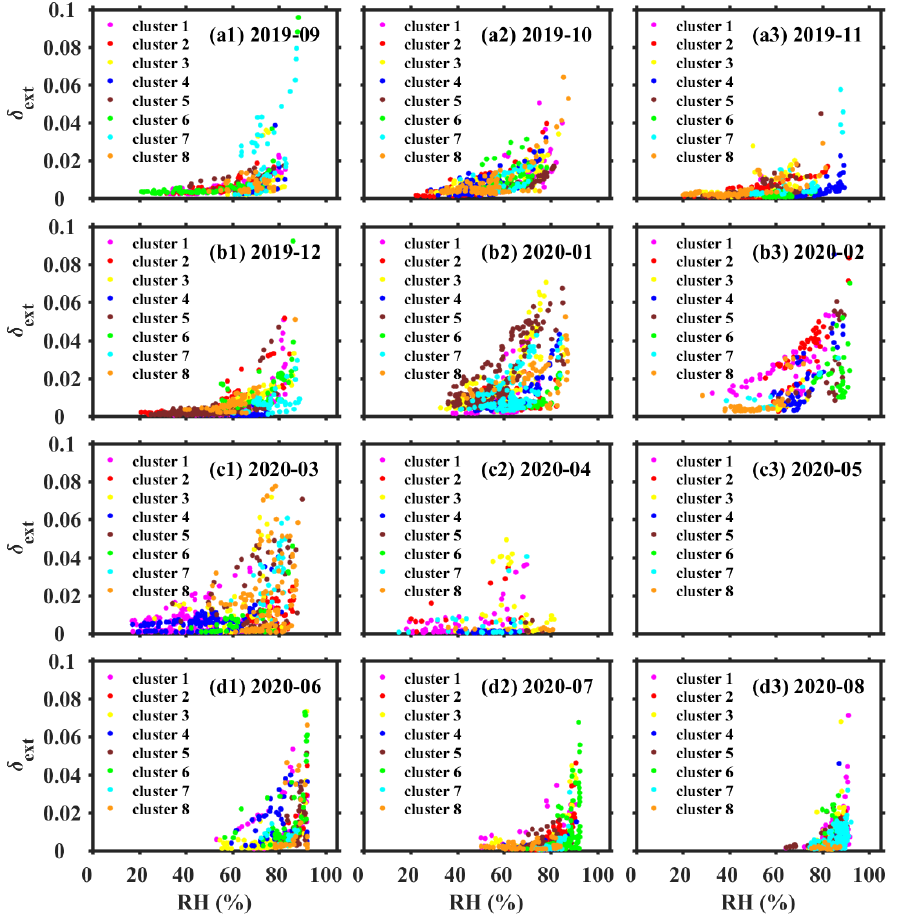
Figure 7. Monthly δ ext distributions of each kind of backward trajectories’ clusters in Qingdao Figure 7. Monthly ext δ distributions of each kind of backward trajectories’ clusters in Qingdao